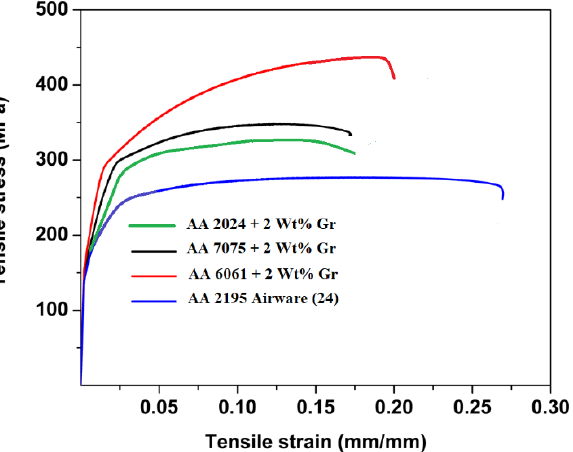
Figure 21. Stress – strain curve comparison between hot extruded graphene nano composites with Aluminium lithium alloys (non-heat treated) (24) used for launch vehicle SLWT external fuel tank structural applications.